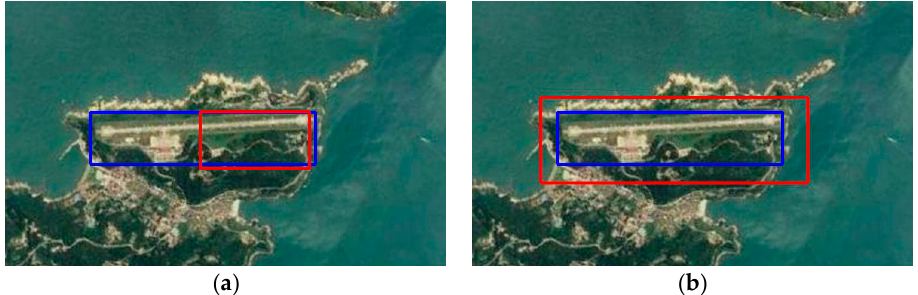
Figure 3. Positive samples at different aspect ratios: ( a ) aspect ratio of 1:2; ( b ) aspect ratio of 1:3. The bounding box of the airport is shown by the blue rectangle, and the positive sample is shown by the red rectangle. [Image courtesy of Google Earth].